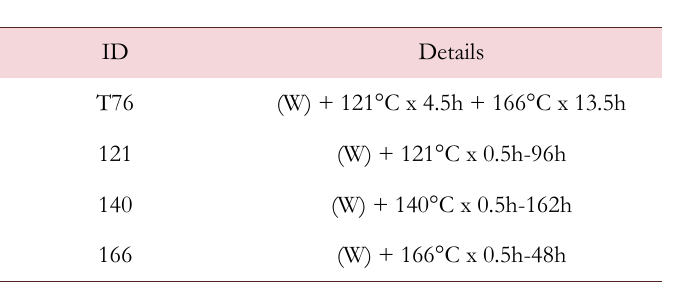
Table 2: Scheme of the different heat treatment conditions.